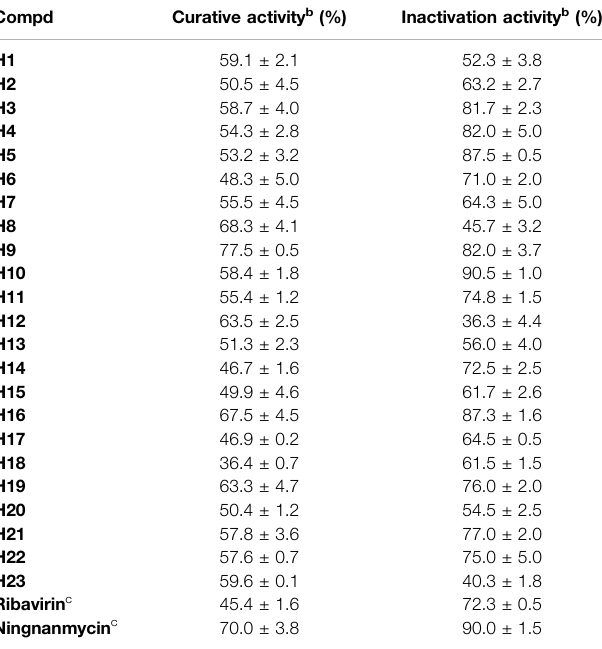
TABLE 5 | Antiviral activities of target compounds against TMV in Vivo at 500 μ g/mL a . Compd